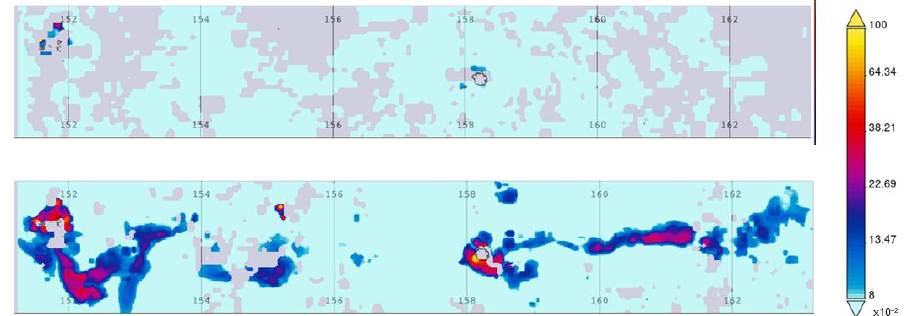
Figure 2. Comparison of MODIS-Aqua 8-day chl a data visualized with NASA Giovanni. ( top ) Time period of 6–14 September 2013. ( bottom ) Time period of 8–24 October 2013. Chuuk Lagoon as located at the northeastern corner of each image, and Pohnpei is approximately centered. The color scale is from 0.08 to 1.0 mg m − 3 . The boundaries of these images are 151.2–163.2 ◦ E, 6–8 ◦ N. Figure 3 shows a climatology of the region for the period 2003–2021, which also used MODIS-Aqua 8-day chl a data products.